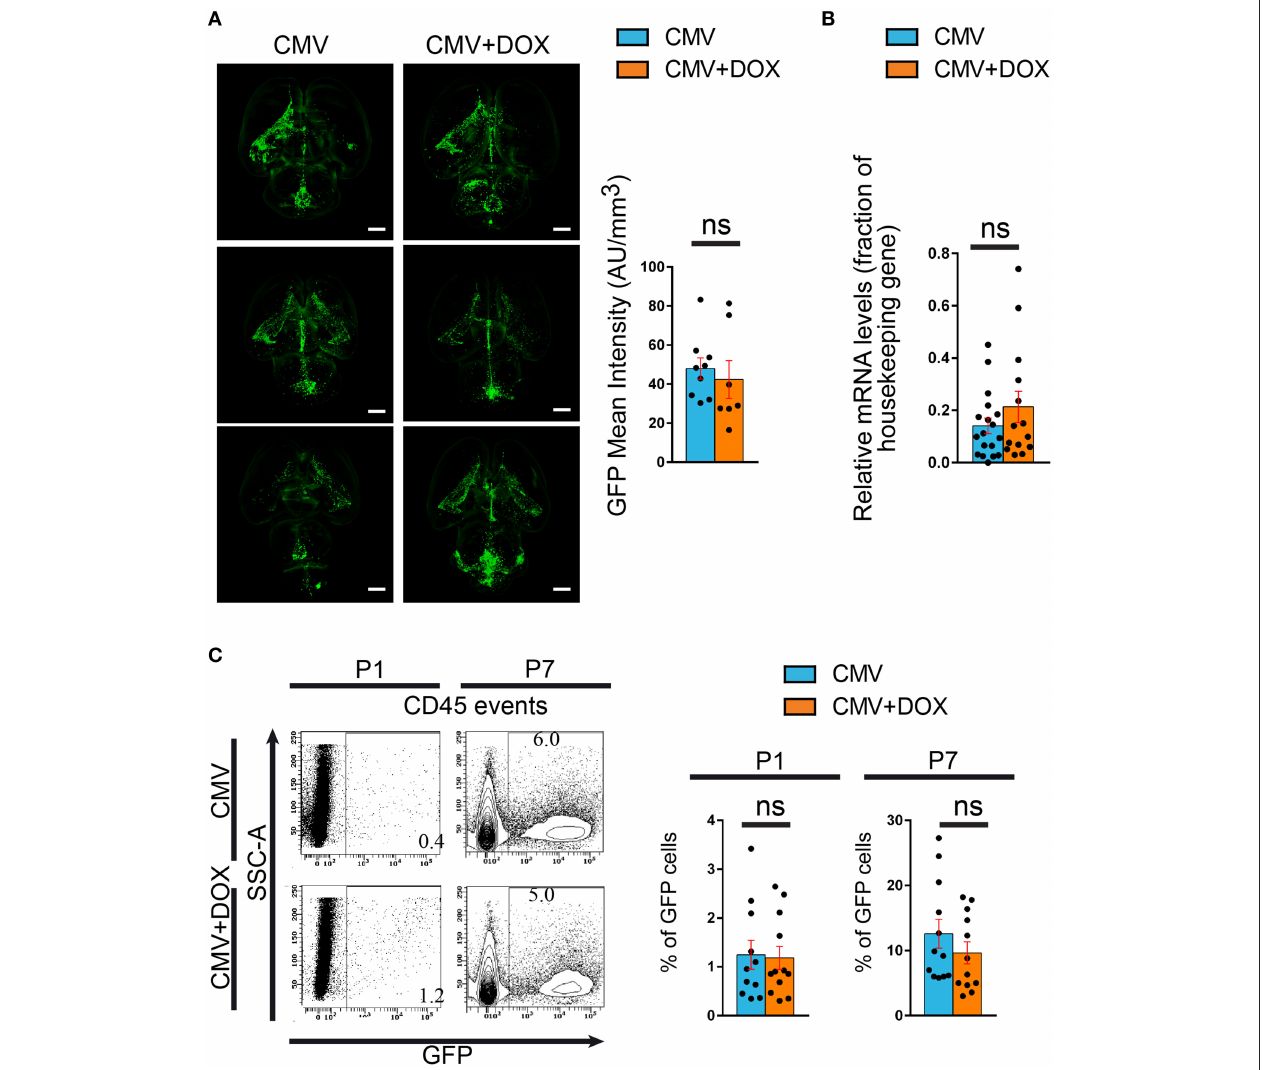
FIGURE 5 | Maternal feeding with doxycycline throughout pregnancy does not impact rat CMV infection of the brain. Green fluorescent protein (GFP) expression was used to monitor infection of the pups’ brains by rat CMV with three independent methods. (A) Tissue clearing. Whole brains from P1 rat pups were submitted to tissue clearing and GFP expression was quantified by measuring mean fluoresence intensity normalized to each corresponding total brain volume. Representative examples of clarified brains are shown (light sheet microscopy) (see also Supplementary Videos 1, 2). No significant difference was found between the CMV + DOX group ( n = 7) and its untreated counterpart (CMV; n = 9). Bar: 2mm. Mann Whitney test, two-tailed. ns, not significant. (B) qRT-PCR. Relative mRNA expression of GFP was assessed by quantitative RT-PCR in CMV-infected brains at P1, using RPL-19 as reference gene. No difference was found between the CMV + DOX group ( n = 14) and its untreated counterpart (CMV; n = 18). Values of fold change represent averages from triplicate measurements for each sample. Mann Whitney test, two-tailed. ns: not significant. (C) Flow cytometry. Relative proportion of GFP + , CMV-infected cells was estimated by flow cytometry analysis of CD45 + cells isolated